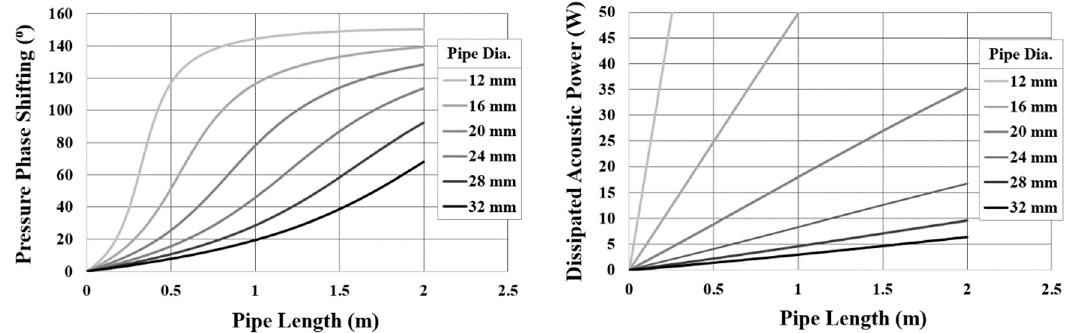
Figure 15. Effect of pipe length and diameter of the inertance pipe on ( a ) pressure phase shifting; ( b ) dissipated acoustic power.